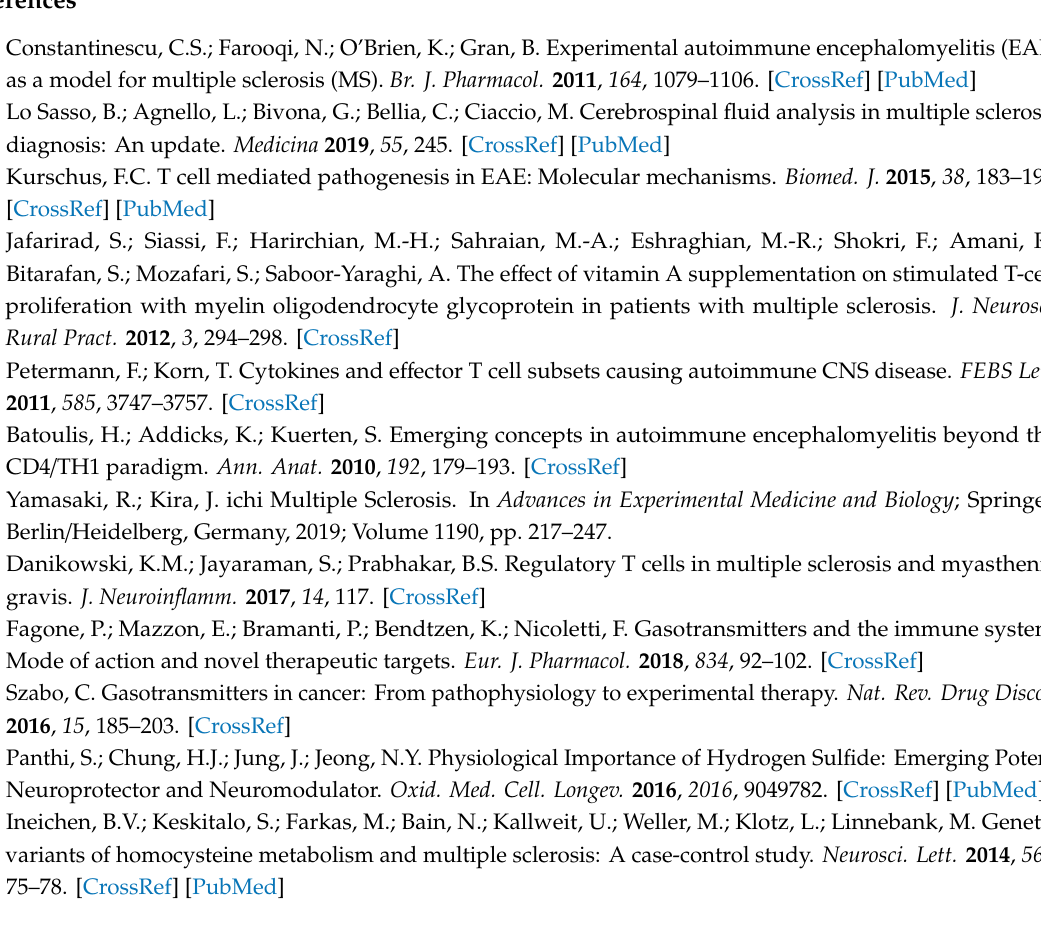
Figure S1: Treg gating strategy, Figure S2: Th17 gating